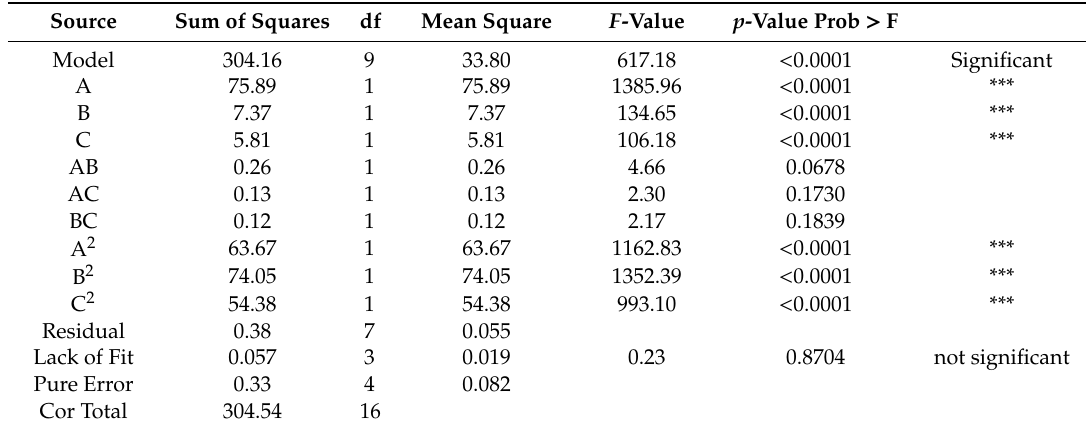
Table 3. Analysis of variance for regression